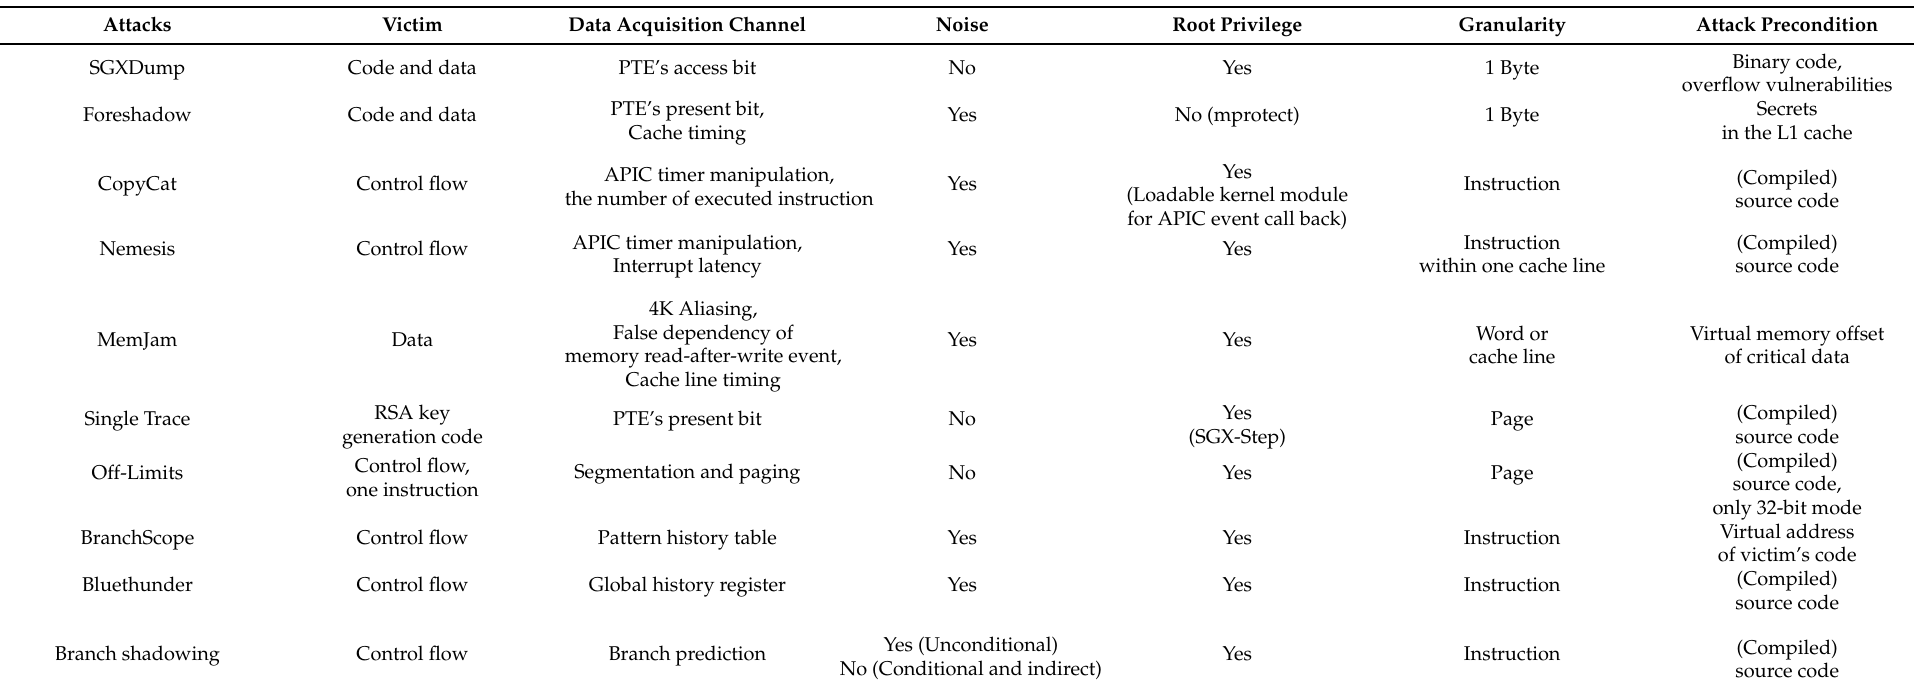
Table 4. Comparison of the side-channel attacks against Intel